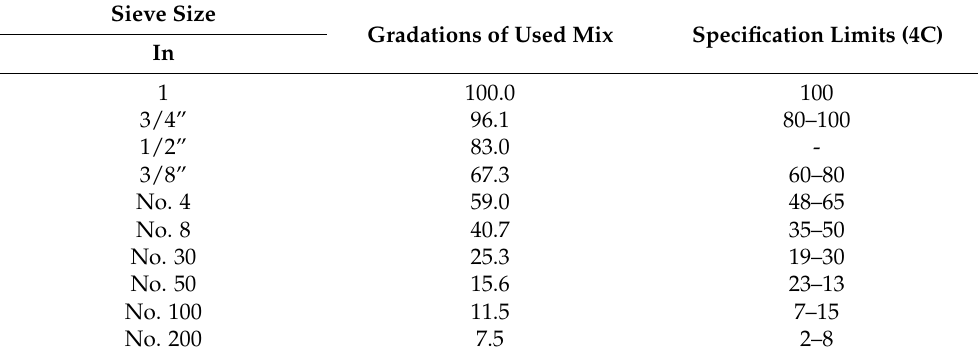
Table 1. The gradation of the used mix and specification limits.